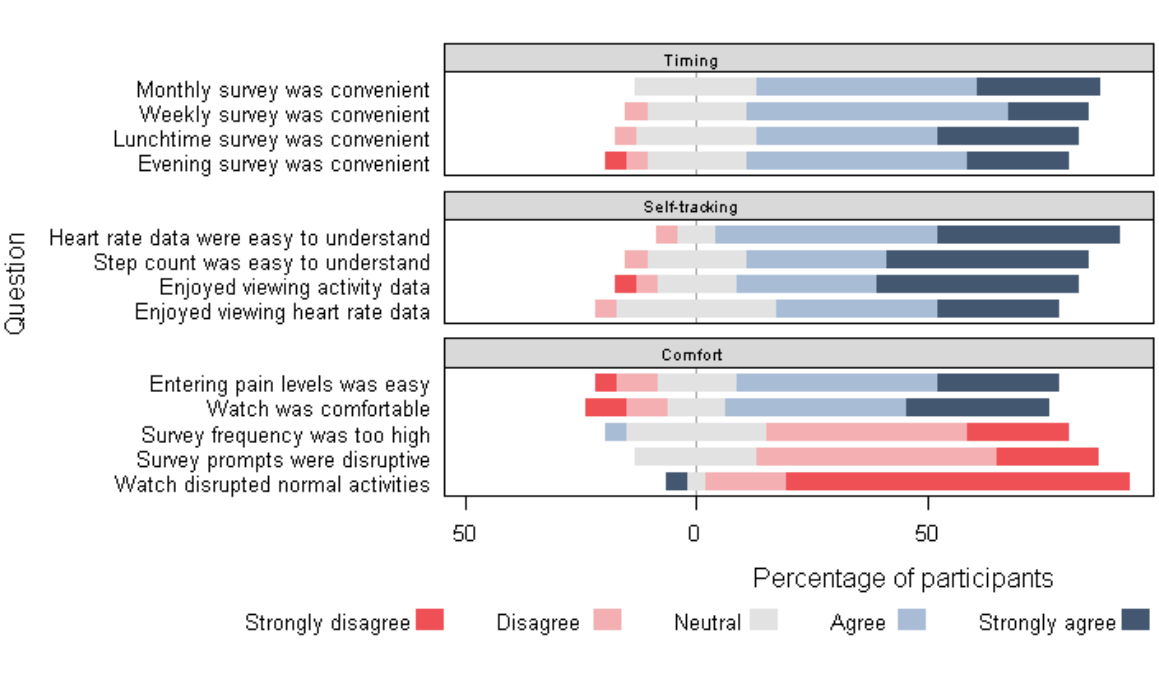
Figure 5. End-of-study study survey—Comfort, convenience of prompts, and self-tracking. Proportion of participants (100%=23) that chose a specific answer; bars to the right of zero reflect positive